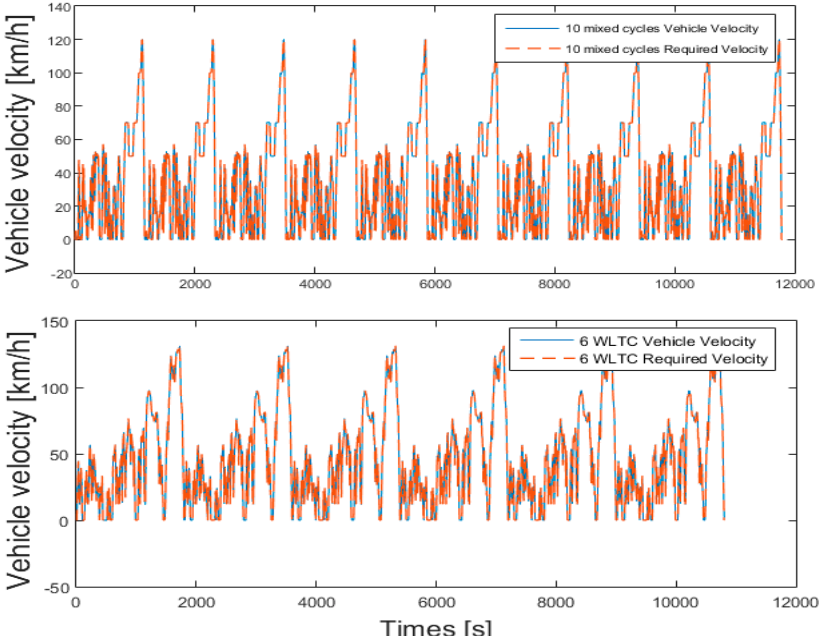
Figure 16. Vehicle velocity and required velocity variation of the proposed online L-Control algo- rithm for PHEV during 10 MIXED cycles, 6 WLTC, and 10 NEDC